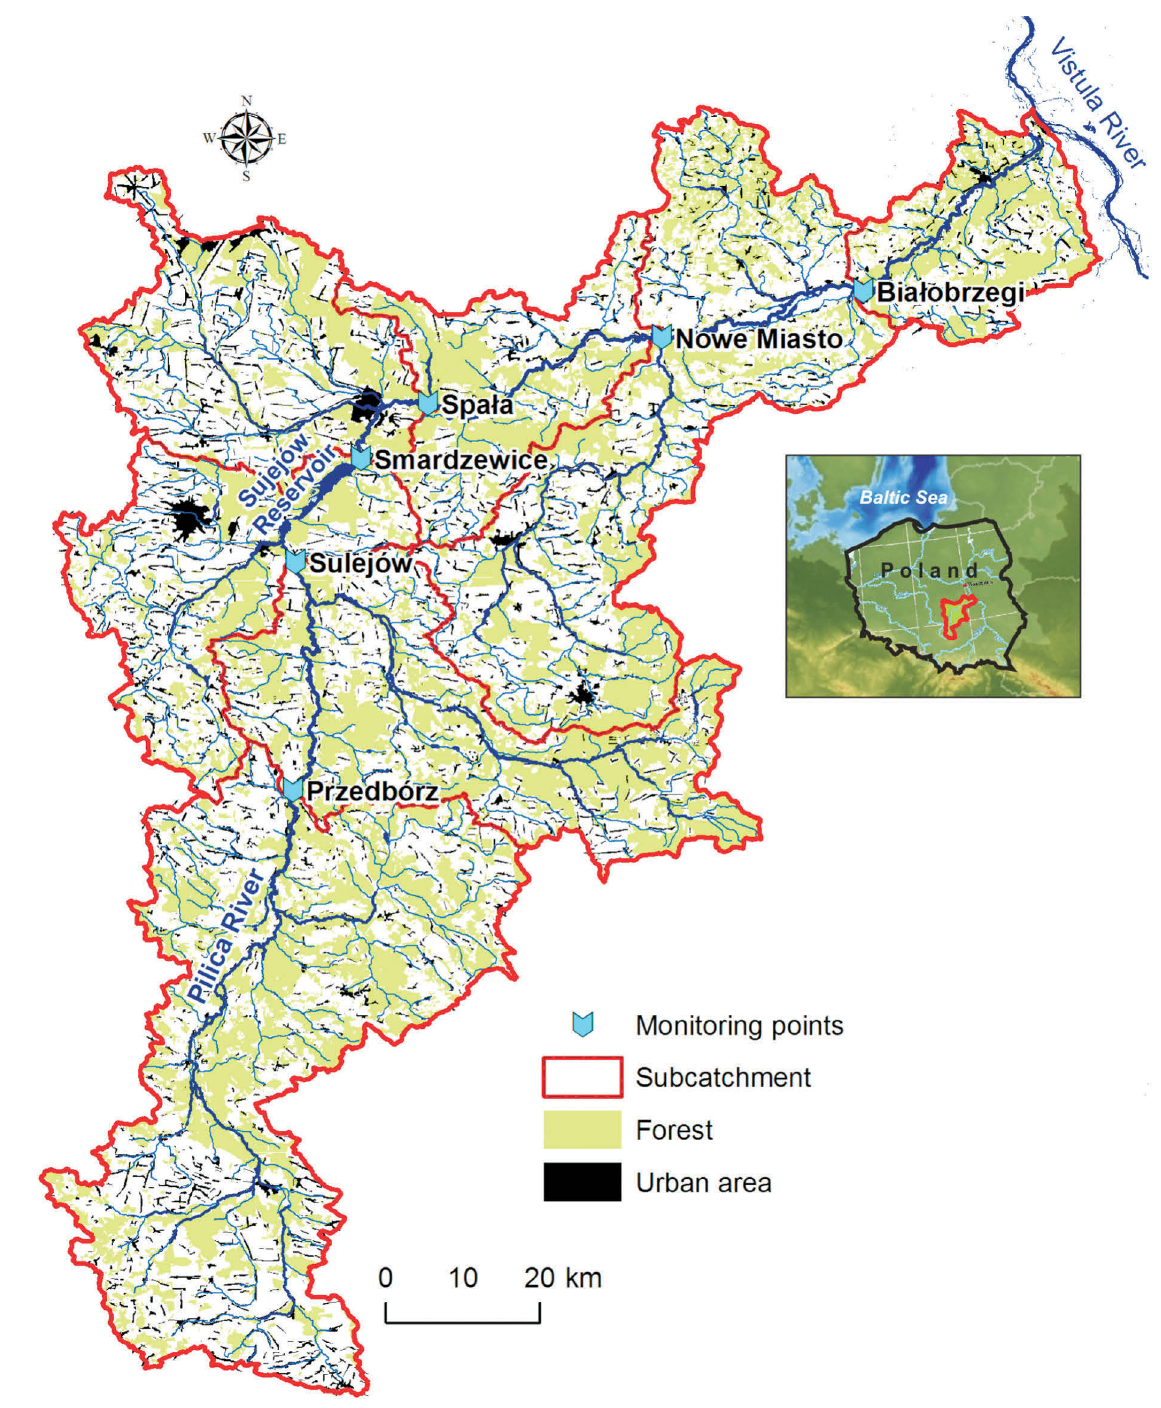
Fig. 2. General land cover and location of the monitoring points and sub-catchments in the Pilica River basin (central